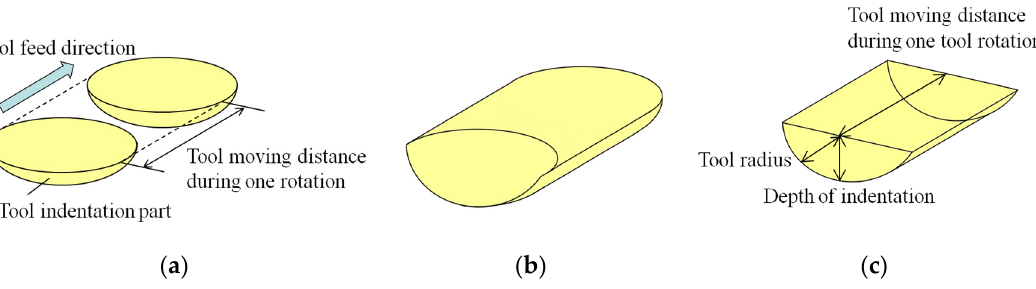
Figure 8. Schematic of stirred volume by the FSB tool: ( a ) Tool indentation part and tool movement; ( b ) The volume that is stirred by the tool passing during one rotation; and ( c ) Calculation of stirred volume during one tool rotation.